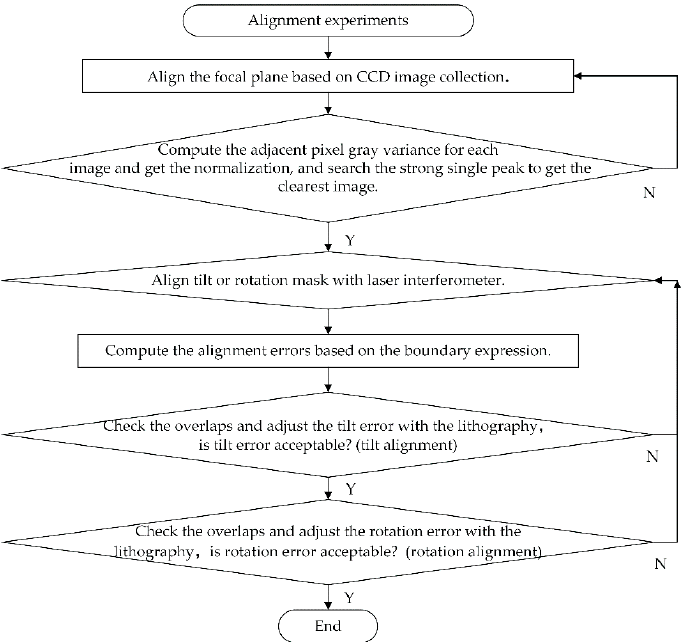
Figure 7. Flowchart of alignment experiments.